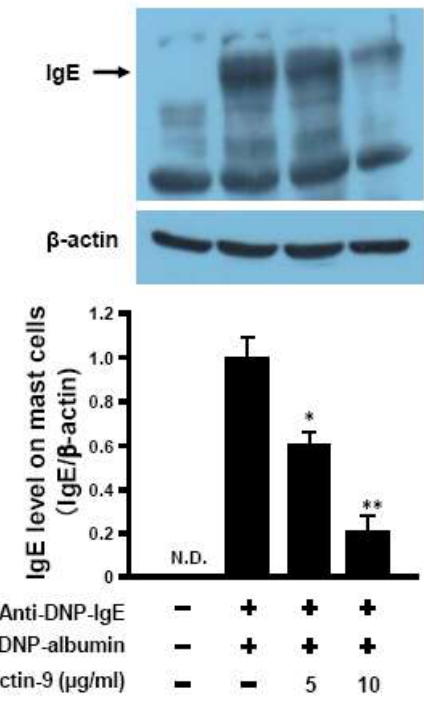
Figure 7. Galectin-9 decreases IgE contents on mast cells. RBL-2H3 cells were incubated with anti DNP-IgE (1 μg/mL) overnight and then incubated with or without recombinant galectin-9 for 2 h. The cells were collected and lysed to obtain the proteins. IgE level in the samples were measured by western blotting analysis. * p < 0.05, ** p < 0.01 significantly different from the values of group that was added IgE and incubated without recombinant galectin-9. Values represent the means ± SE ( n = 3).